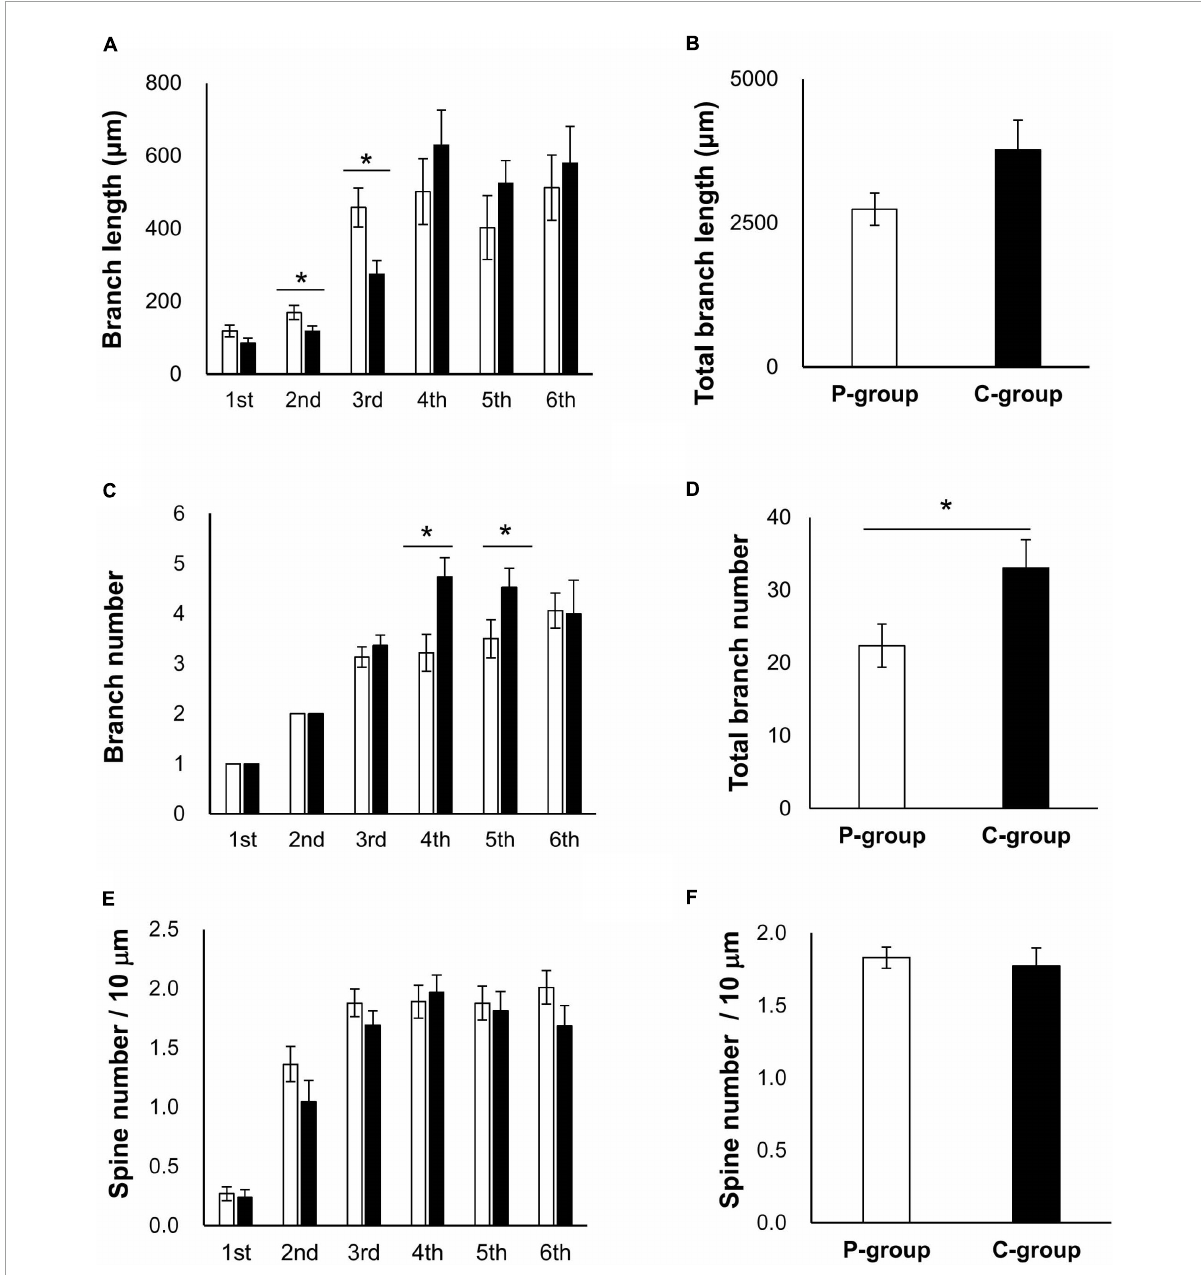
FIGURE3 Effect of mastication stimuli on the apical dendrites of CA1 pyramidal cell. (A) Branch length of dendrites. Branch numbering is illustrated in Supplementary Figure 2 . *: significant differences detected by Student t -test [ t (41) = 2.0526 and p = 0.0465 for the second branch, and t (41) = 2.8105 and p = 0.0075 for the third branch]. (B) Total branch length of dendrites. (C) Branch number of dendrites. *: significant differences detected by Student t -test [ t (42) = 2.7232 and p = 0.0094 for the fourth branch and t (39) = 2.3540 and p = 0.0237 for the fifth branch]. (D) Total branch number of dendrites. *: significant differences detected by Student t -test [ t (42) = 2.2189 and p = 0.0319]. (E) Spine number per branch length. (F) Total branch density per dendrite length. (cid:3) : P -group, (cid:4) : C-group. Sample numbers were n = 15–23 for each